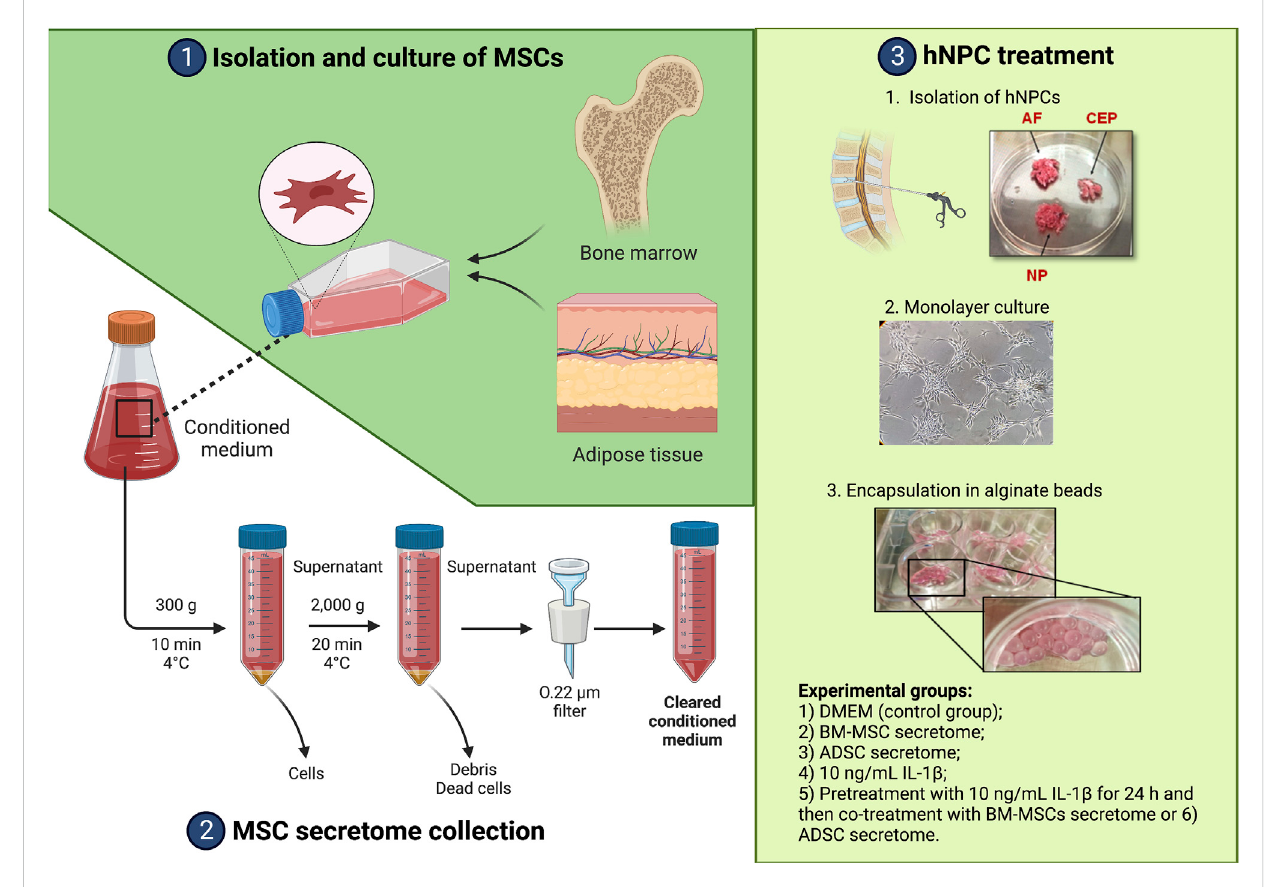
FIGURE 1 Summary of the experimental work fl ow. Created with